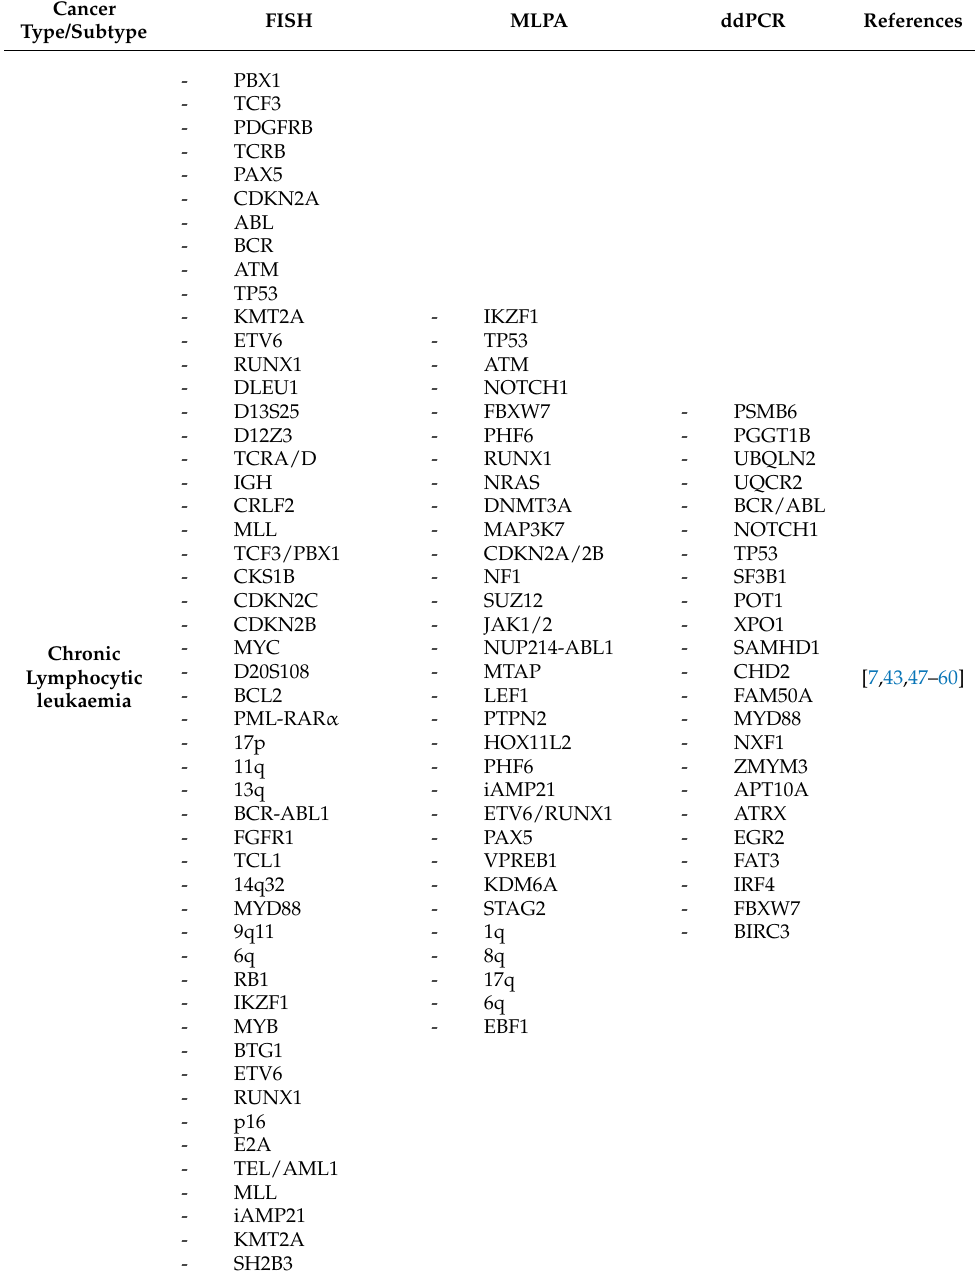
Table 1. Molecular targets investigated by the three techniques FISH, MLPA and ddPCR in the type of tumors described in the